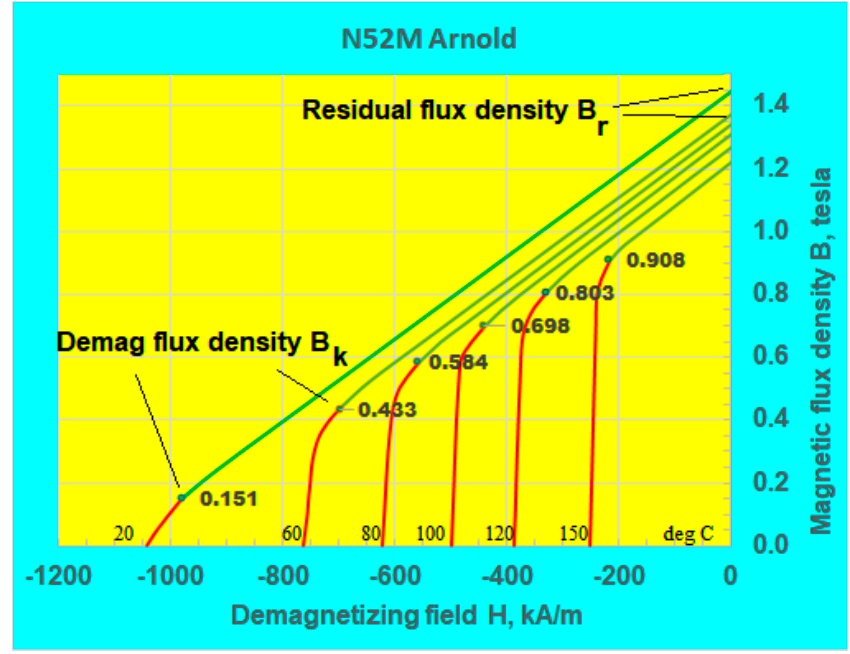
Figure 6. Simplified representation of the demagnetization curves for magnets.